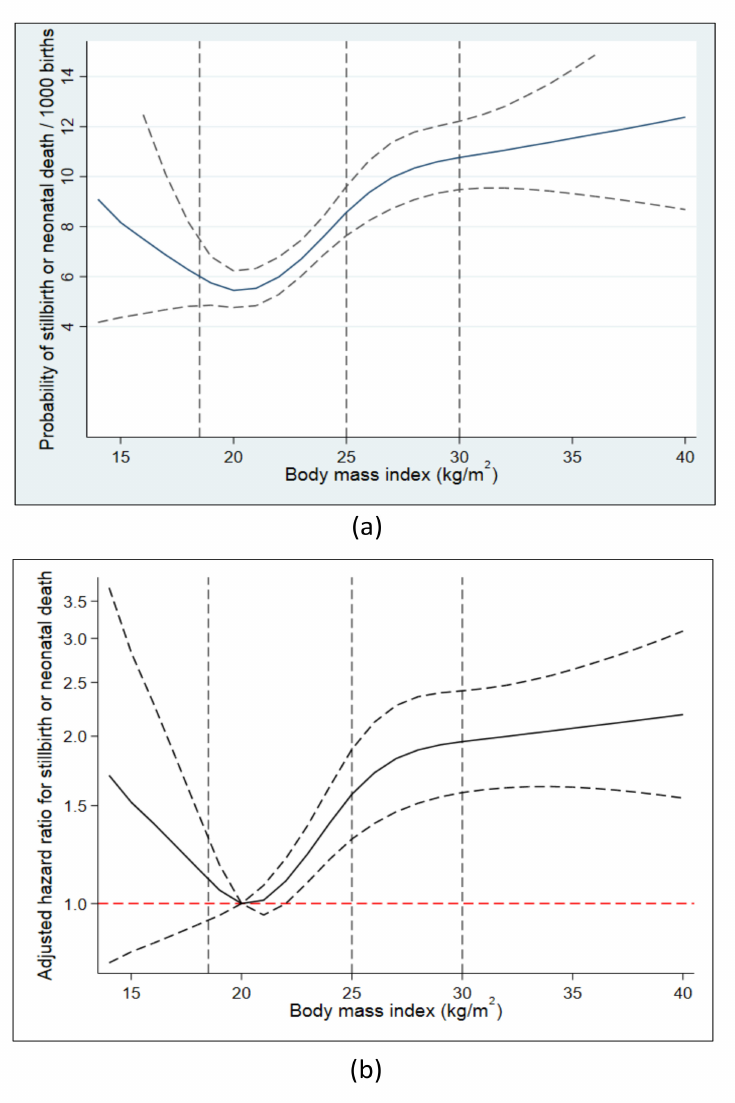
Figure 1. Absolute risks ( a ) and adjusted hazard ratios ( b ) for stillbirth or neonatal death according to prepregnancy